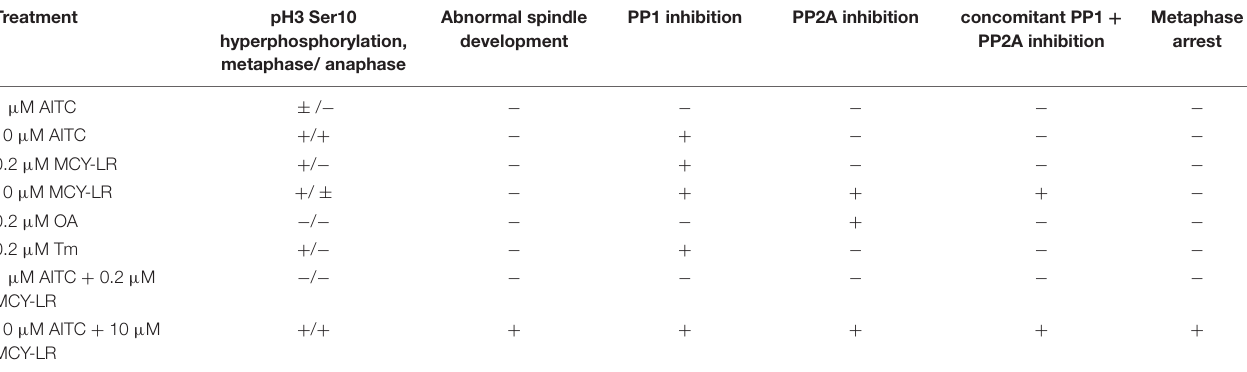
TABLE 1 | A summary of cytological and biochemical effects of 12 h AITC treatments with or without MCY-LR as well as of OA and Tm in lateral root tips. Treatment pH3 Ser10 Abnormal spindle PP1 hyperphosphorylation, development metaphase/ anaphase